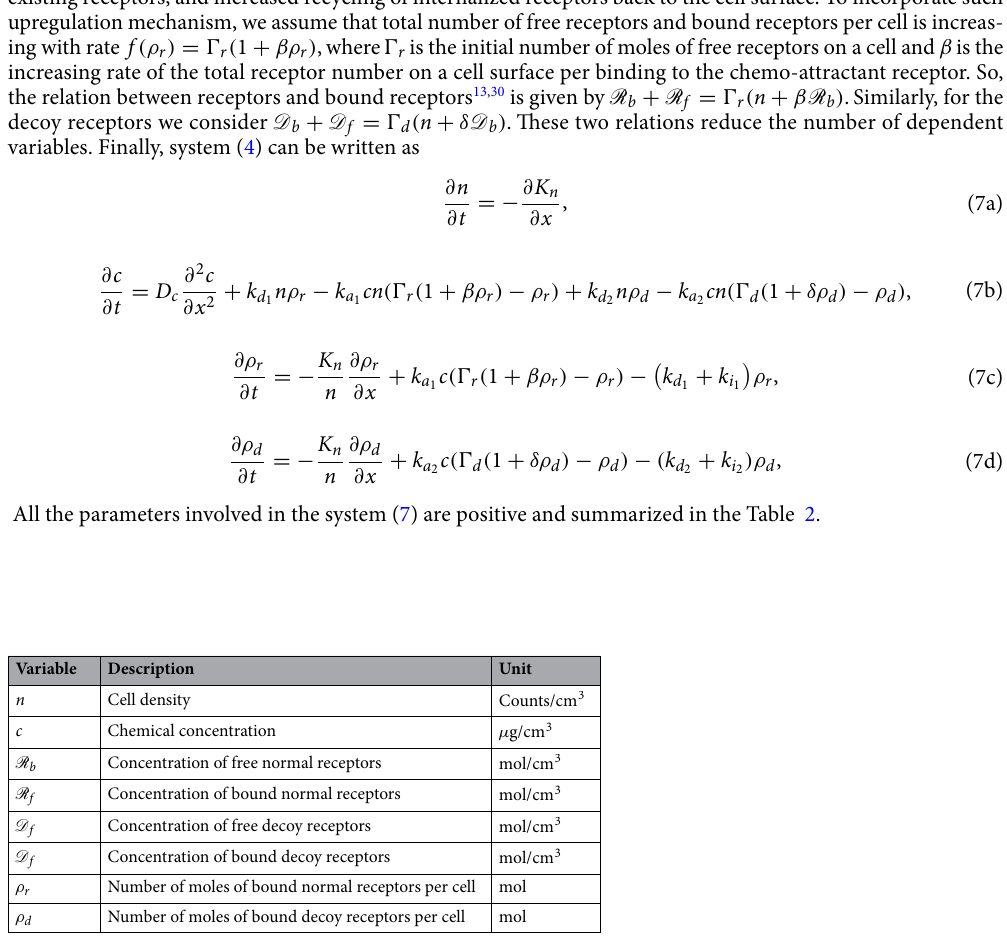
Table 1. Description of the variables used in the